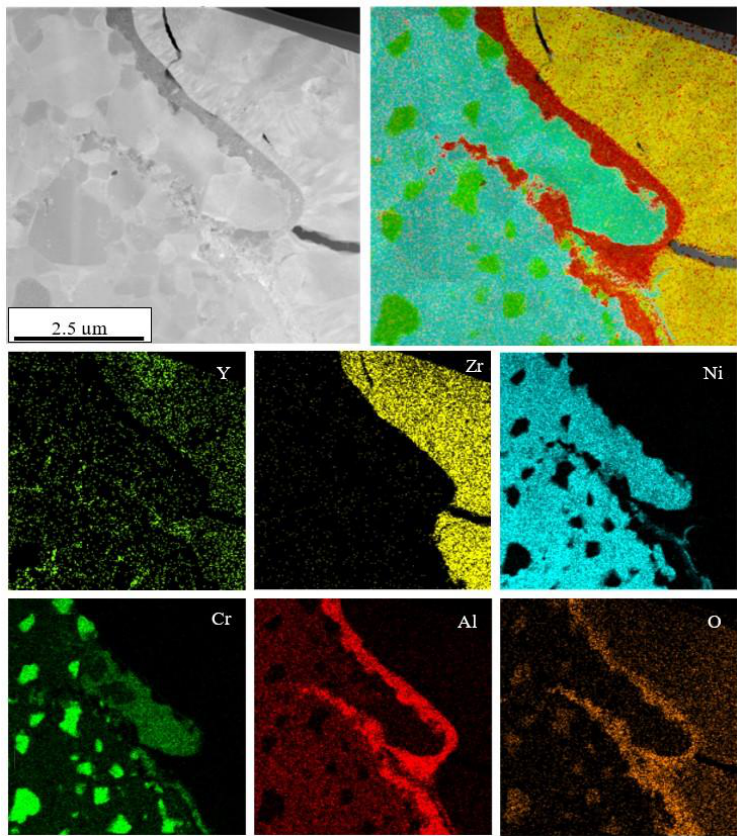
Figure 15. Cross-sectional microstructure and the corresponding EDS mapping of sample, H1080c.